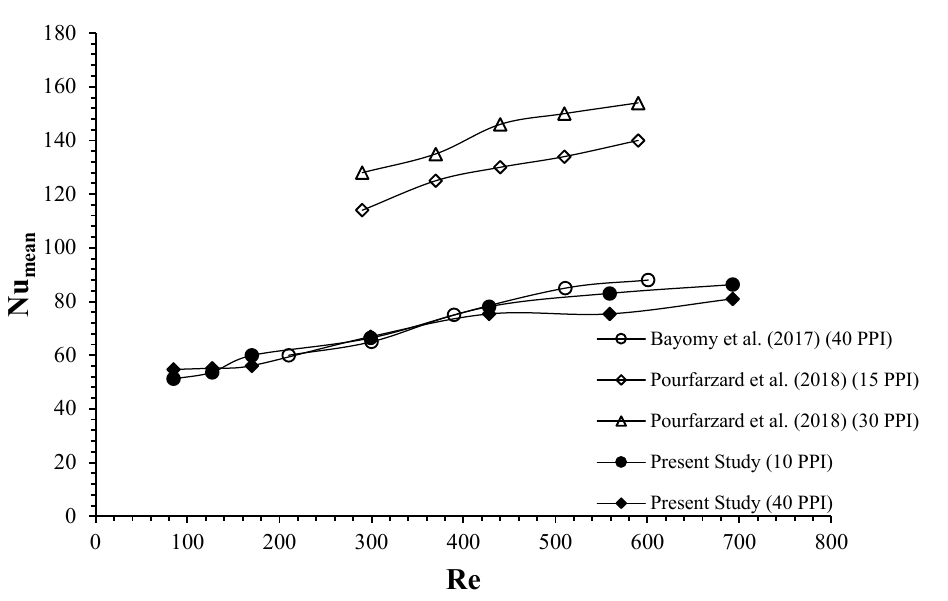
Figure 9. Variation of mean Nusselt number against Reynolds number in various studies Pourfarzard et al. [2], Bayomy et al. [4].